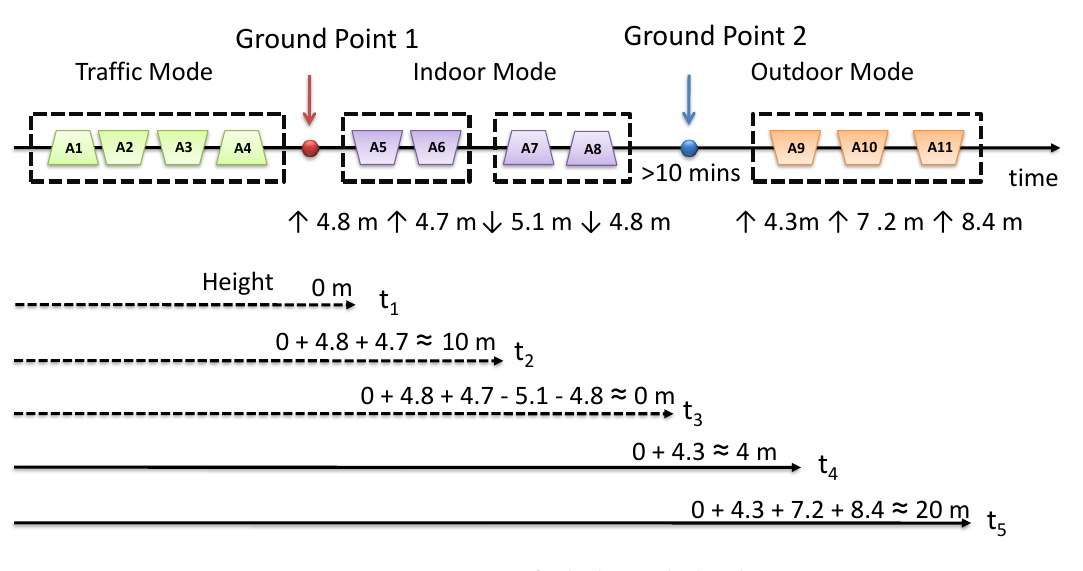
Figure 8. Overview of calculating the